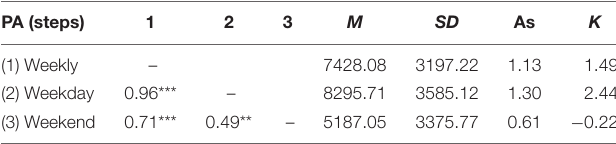
TABLE 1 | Mean ± SD, asymmetry and correlation between total weekly, weekday, and weekend steps.